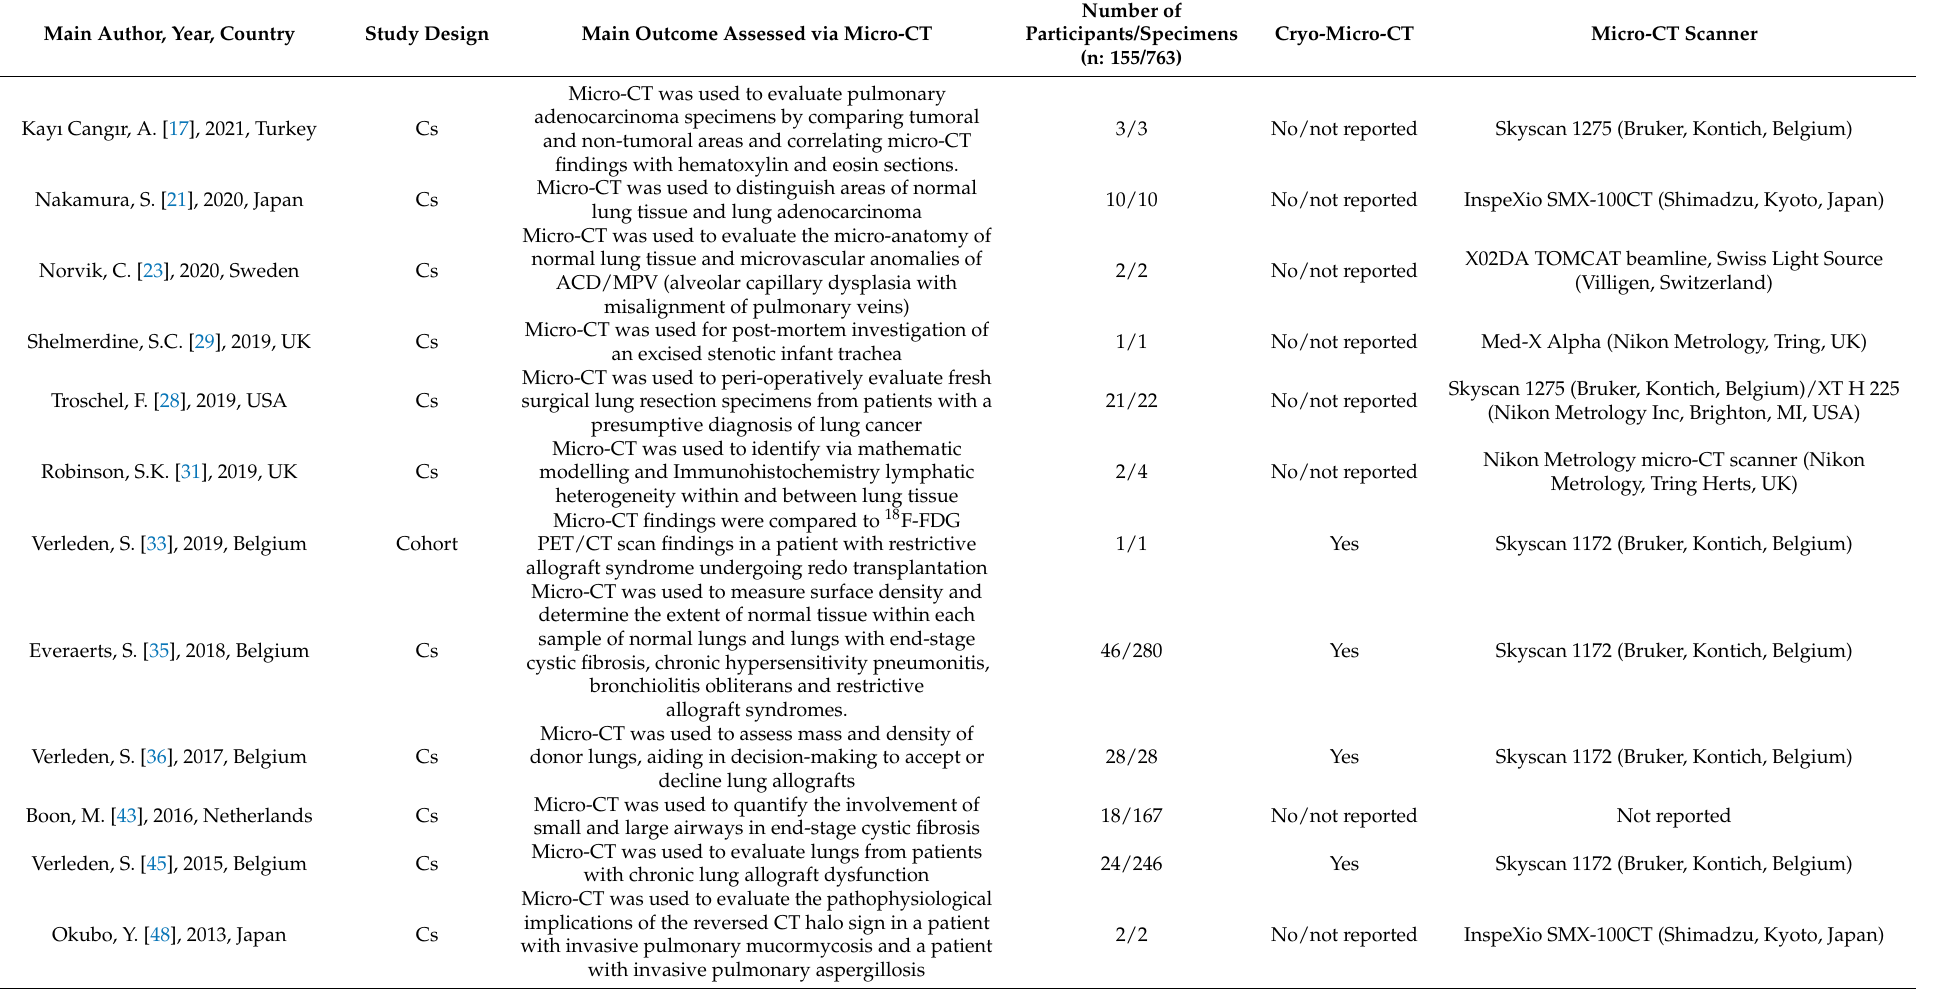
Table 5. Studies using micro-CT for the analysis of pathological lung changes in other disease